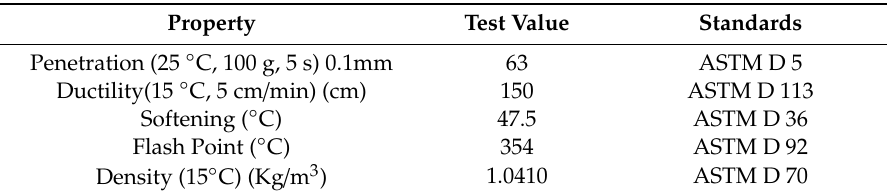
Table 1. Properties of virgin asphalt.